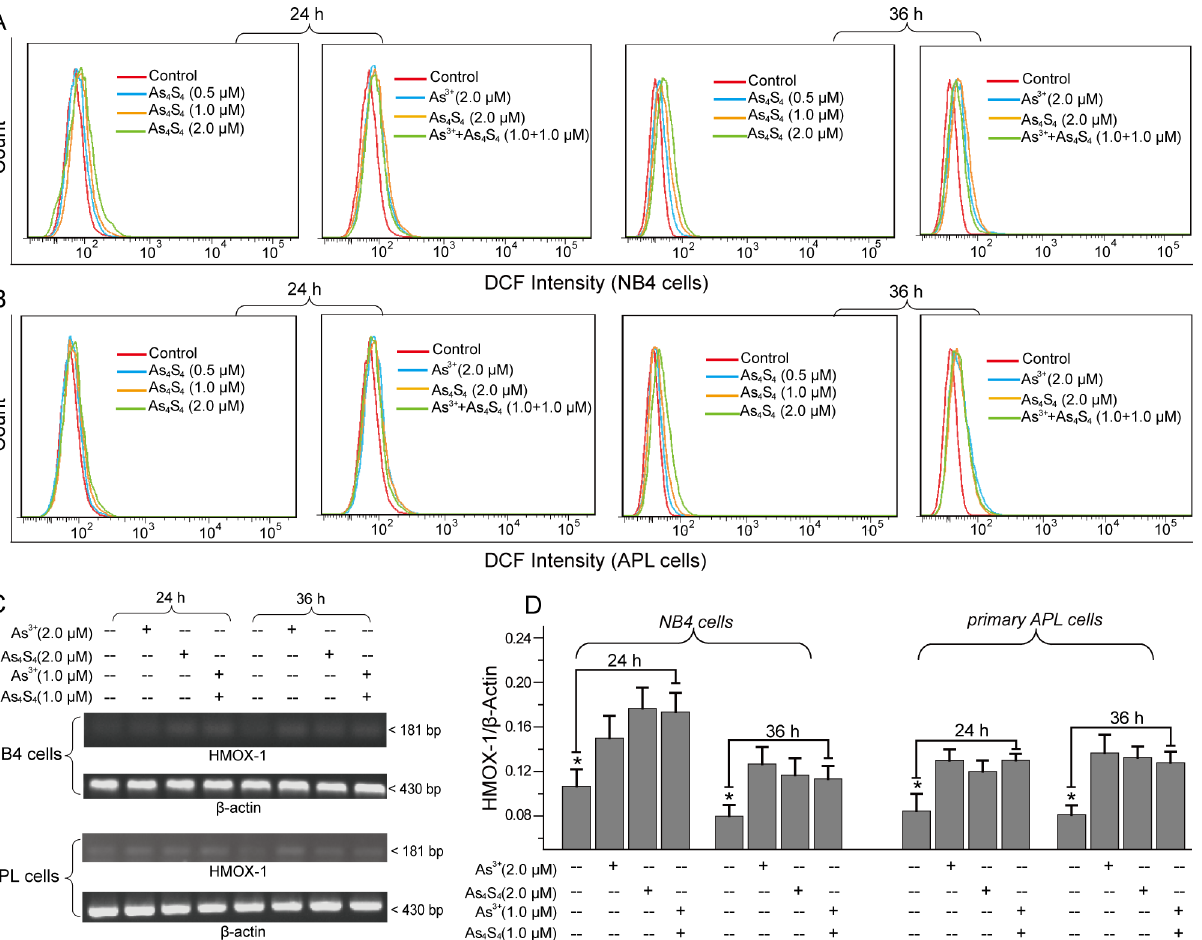
Fig 4. The effects of combining As 3+ and As 4 S 4 on cellular ROS accumulation. (A) Cellular ROS were determined with DCFH-DA fluorescence probe in NB4 cells. (B) Cellular ROS in primary APL cells. (C) The effects of As 4 S 4 and As 3+ on HMOX1 expression. (D) The percentage of relative HMOX1 intensity obtained by RT-PCR. Error bars represent the S.D. from the mean of three independent experiments. * P < 0.05 compared with As 3+ and As 4 S 4 combination treated cells.